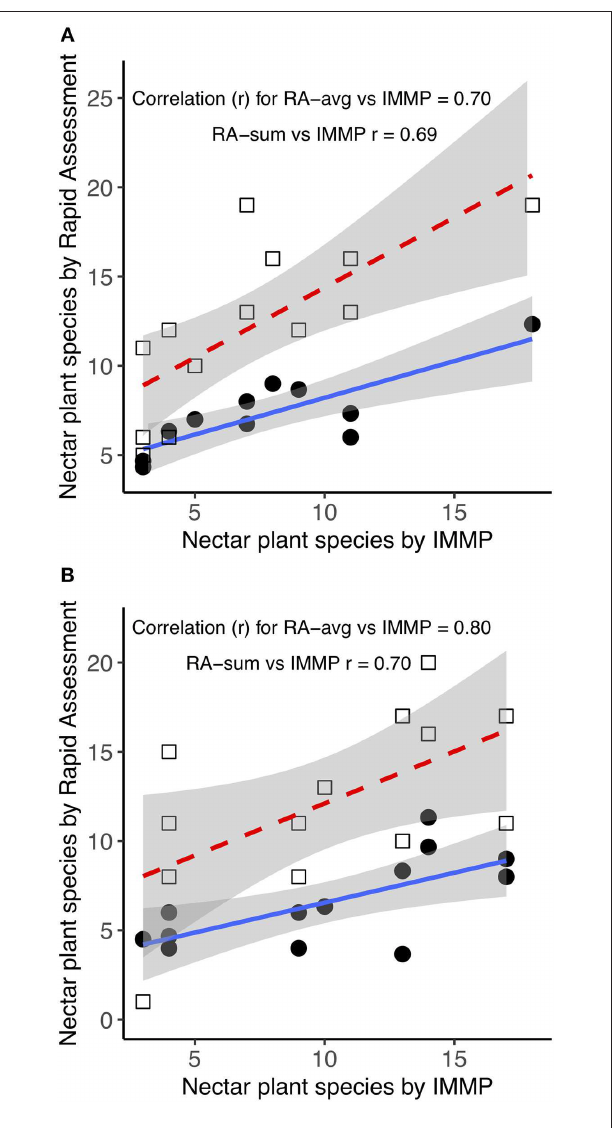
FIGURE 7 | Number of blooming plant species in 2017 (A) and 2018 (B) comparing data by averaging from several Rapid Assessments (RA averaged, in orange) or when summed across the Rapid Assessments (RA summed, in gray), compared to the number derived from the Integrated Monarch Monitoring Protocol (IMMP) for each